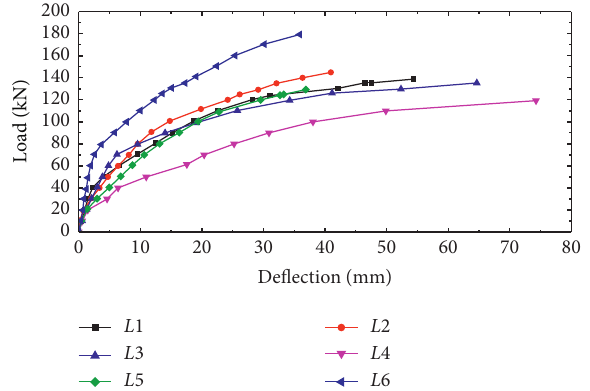
Figure 7: Load and deflection relationships.